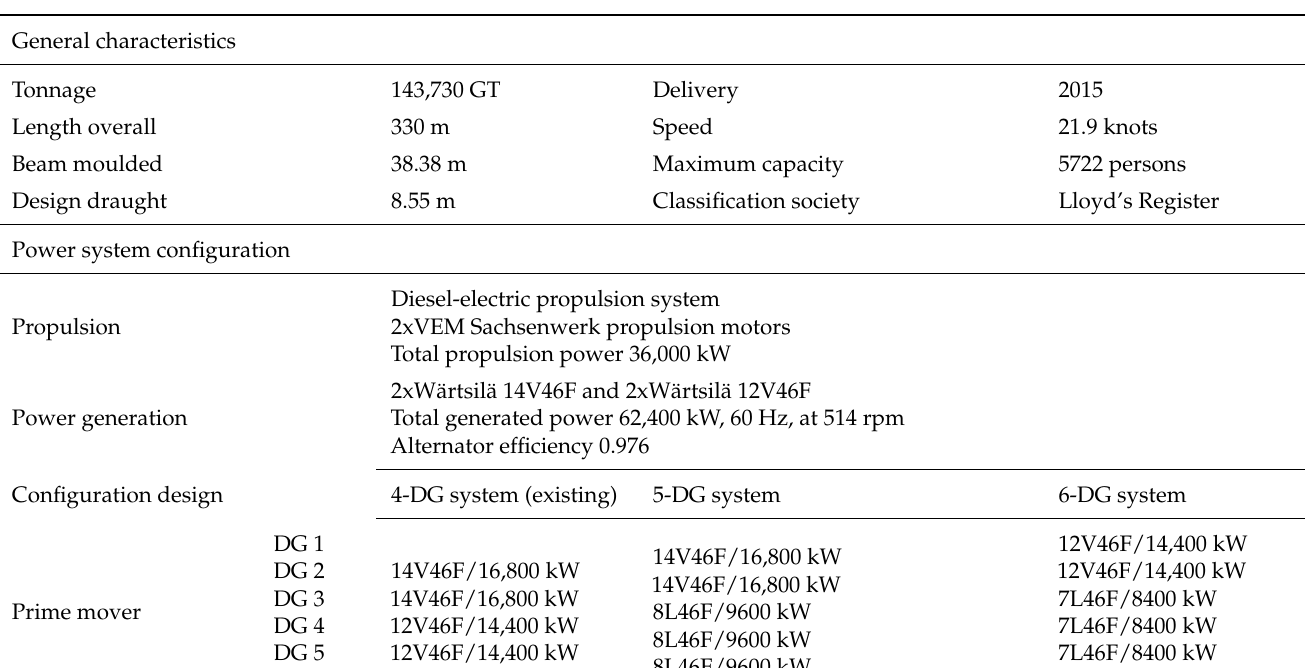
Table A1. Parameters for the Britannia -class